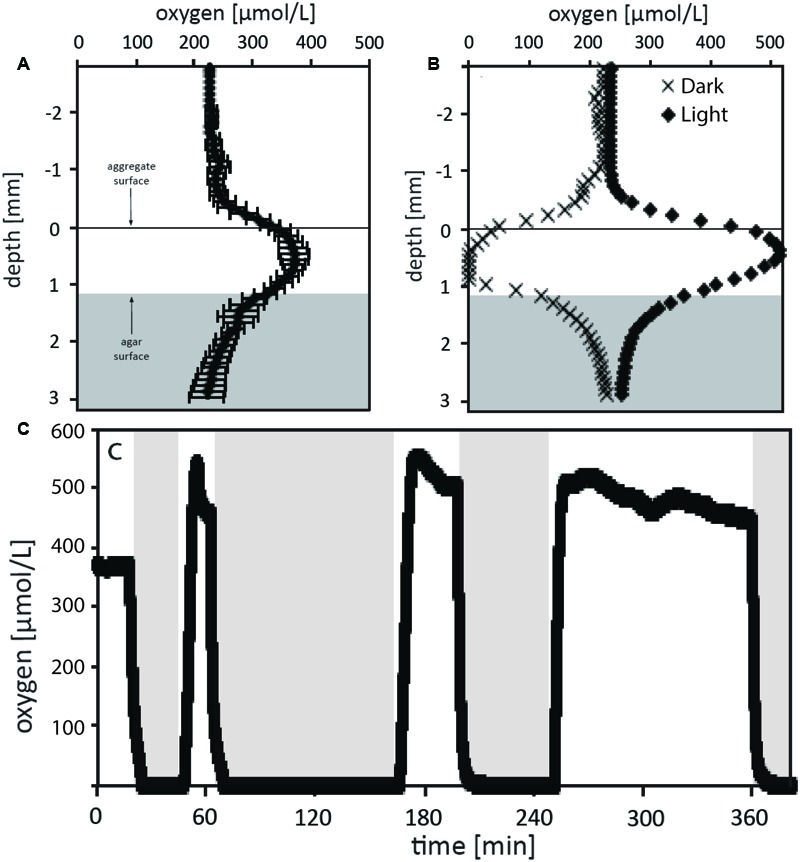
Oxygen measurements of the green berry aggregates in light and dark conditions. (A) Depth microprofiles with oxygen microsensors were conducted for 3 similar aggregates under steady state illumination with 170 μE m-2 s-1. The average O2 concentration versus depth relative to aggregate surface is plotted for these aggregates. (B) O2 profiles were measured for an aggregate under conditions of steady state illumination at 320 μE m-2 s-1 (black diamonds) and steady state darkness (black Xs). (C) The O2 microsensor was positioned at the center of an aggregate which was then exposed to series of different illumination conditions over a time course while concentration was monitored. Initial conditions recorded were at 170 μE m-2 s-1 followed by shift to darkness, and three subsequence rounds of illumination at 320 μE m-2 s-1 followed by dark shifts. Dark periods are indicated by the position of the light gray boxes.